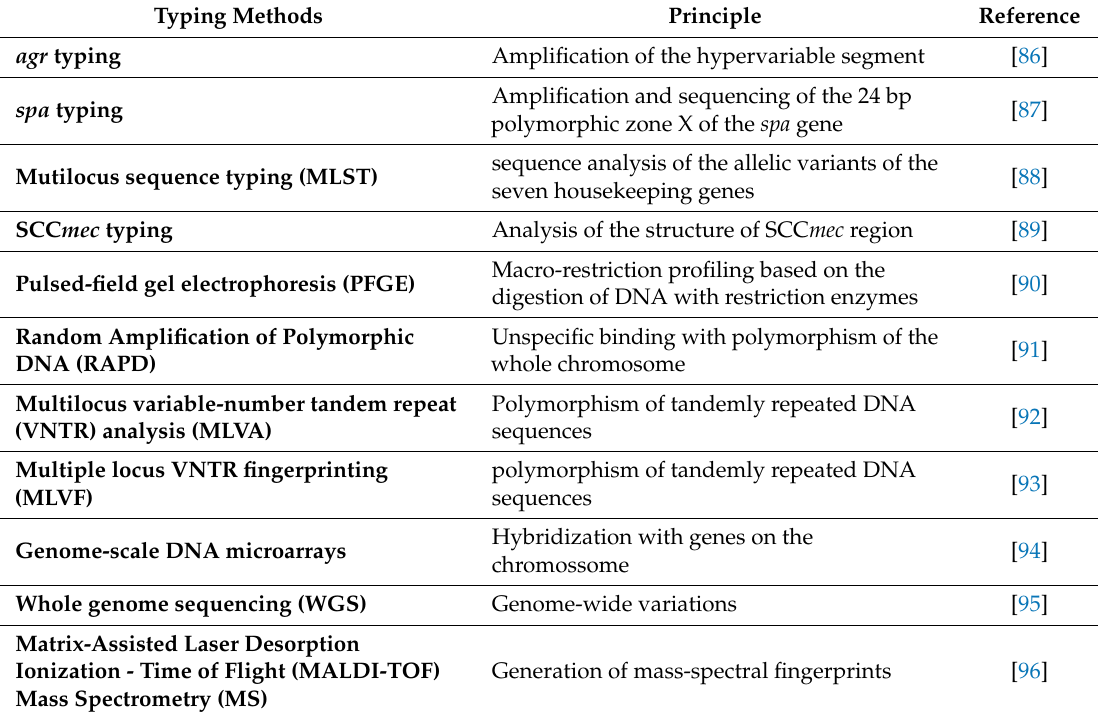
Table 1. Molecular typing methods for S.